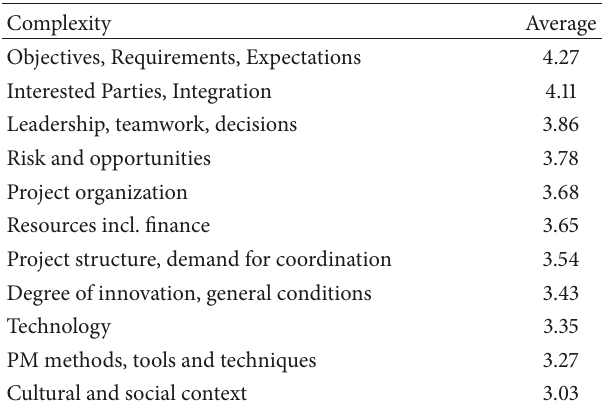
Table 6: Summary of Questions related to complexity